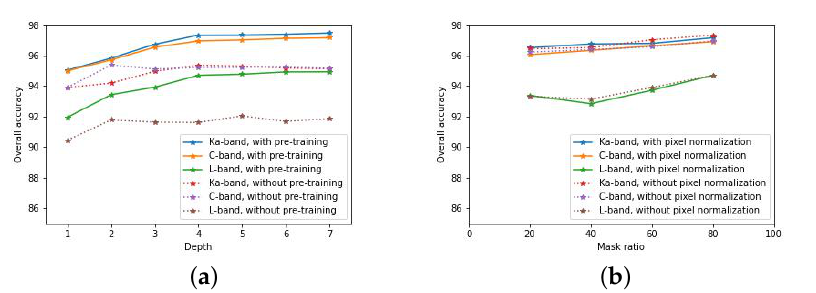
Figure 11. The results of ablation experiments. ( a ) The overall accuracy at different model depths and whether pre-training is used, with a fixed mask ratio 0.8 and no pixel normalization. ( b ) The overall accuracy at different mask ratios and different approaches of pixel normalization, with a fixed model depth